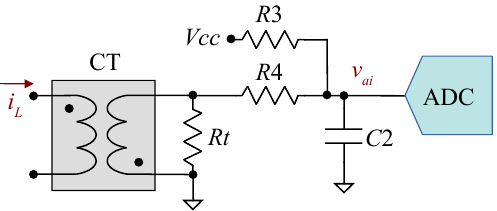
Figure 6. Acquisition chain for the inverter load current.